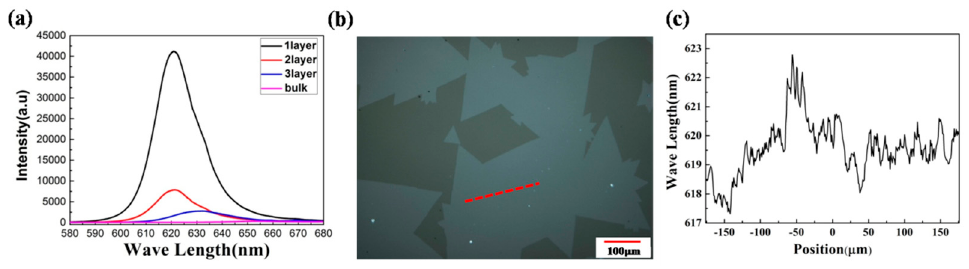
Figure 6. ( a ) Photoluminescence (PL) spectra of WS 2 with different thickness; ( b ) optical image of WS 2 and the red line is position for PL line scanning; ( c ) PL line scanning image.